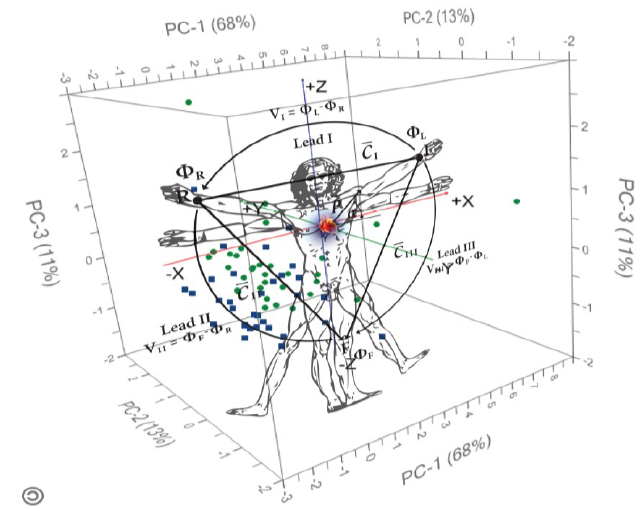
Figure 9. The Modern Vitruvian Man. Da Vinci‘s Vitruvian man, often used as a symbol of humanity, was drawn to demonstrate the proportions of the human body but with the purpose of relating man to nature. In his anatomical drawings and in Vitruvian Man, he considered a cosmografia del minor mondo (Cosmography of the microcosm). With increasing evidence that the human body comprises not only its own vast number of nucleic acids, proteins, metabolites, etc ., but also those of its microbiome [95], Da Vinci‘s perception of the human body as a universe of interacting molecules is at once both late-medieval and ‗modern‘. It would seem that the only universe capable of containing the human person is an irreversibly personalizing universe